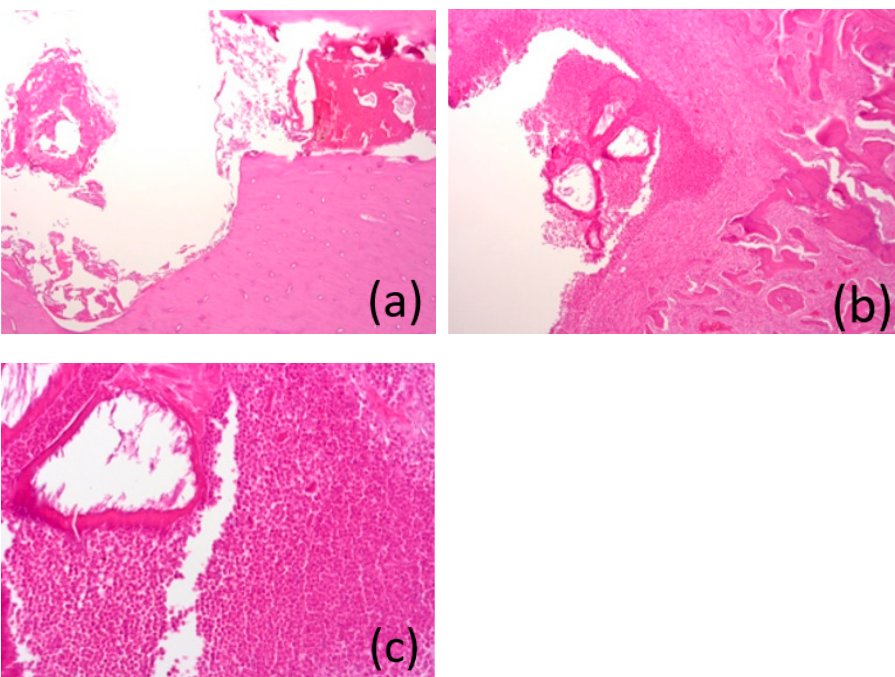
Figure 15. ( a – c ) Images of the histological preparations of a sample removed after 1 month and stained with hematoxylin and eosin, using a microscope at magnifications of ×50 ( a ), ×50 ( b ), and ×200 ( c ).